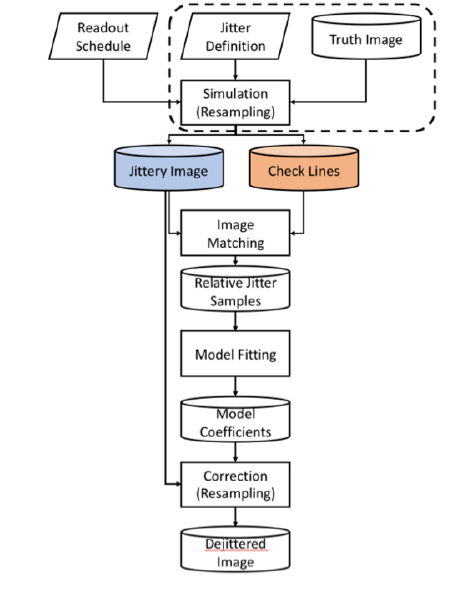
Figure 4. Workflow for simulating images with rolling-shutter jitter distortions (components outlined with a dashed line at upper right) and testing the ability to recover undistorted images. Systematically read main image and check lines are color-coded as in Fig. 3.